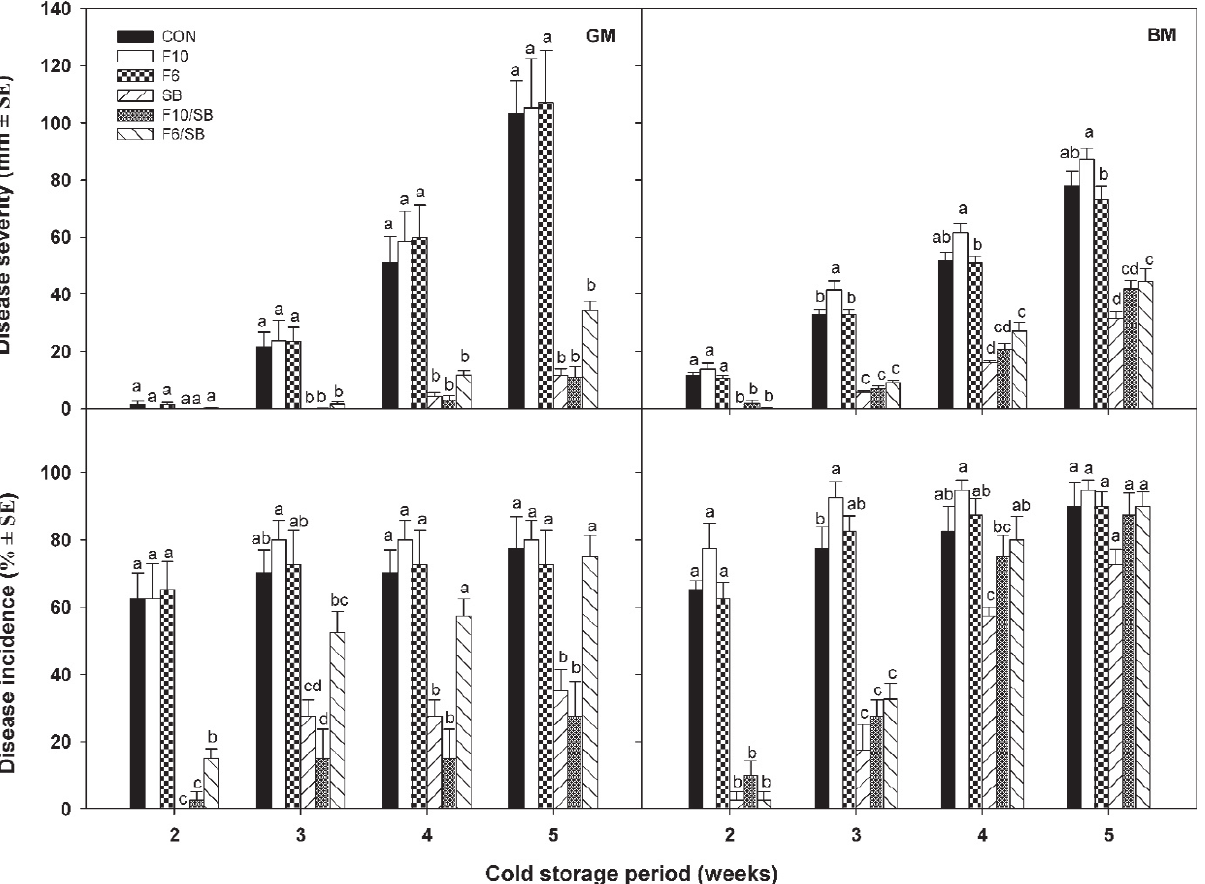
Figure 3. Mean severity and incidence of green mould (GM) or blue mould (BM) on ‘Orri’ mandarins artificially inoculated, respectively, with Penicillium digitatum or P. italicum , then coated 24 h later and cold-stored for 2, 3, 4 and 5 weeks at 5°C and 90% RH. Treatments applied were: control (CON) = uncoated (immersion in water), F10 coating, F6 coating, 2% sodium benzoate (SB) aqueous solution (w/v), F10/SB coating, or F6/SB coating (see Table 2 for coating composition). For each disease and incubation period, columns accompanied by different letters are significantly different (Fisher’s protected LSD test; P < 0.05). Vertical lines above columns indicate standard errors. Inci- dence values were arcsine-transformed before statistical analyses. Non-transformed means are